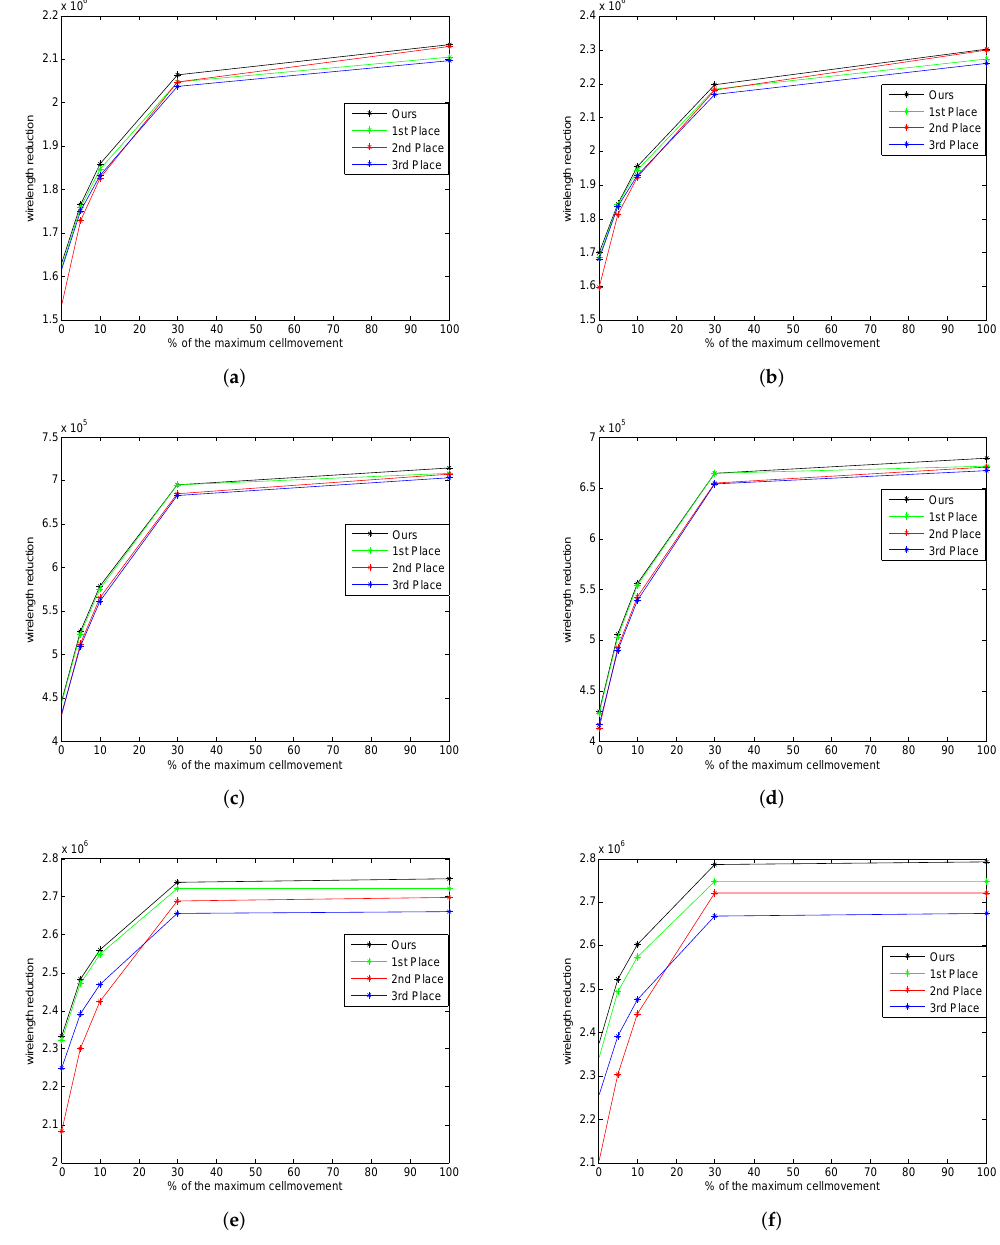
Figure 10. Experimental results with relaxed max cell movement constraint. ( a ) Case4. ( b ) Case4b. ( c ) Case5. ( d ) Case5b. ( e ) Case6. ( f )